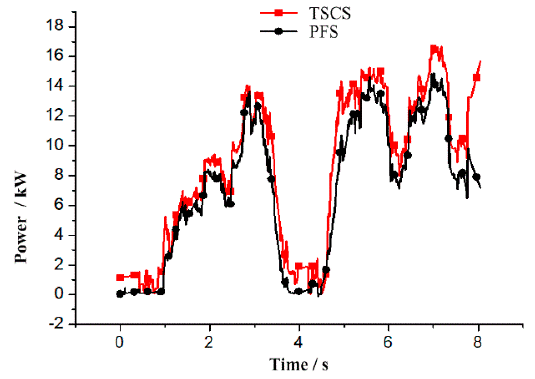
Figure 16. Pump output power curves of the two systems.